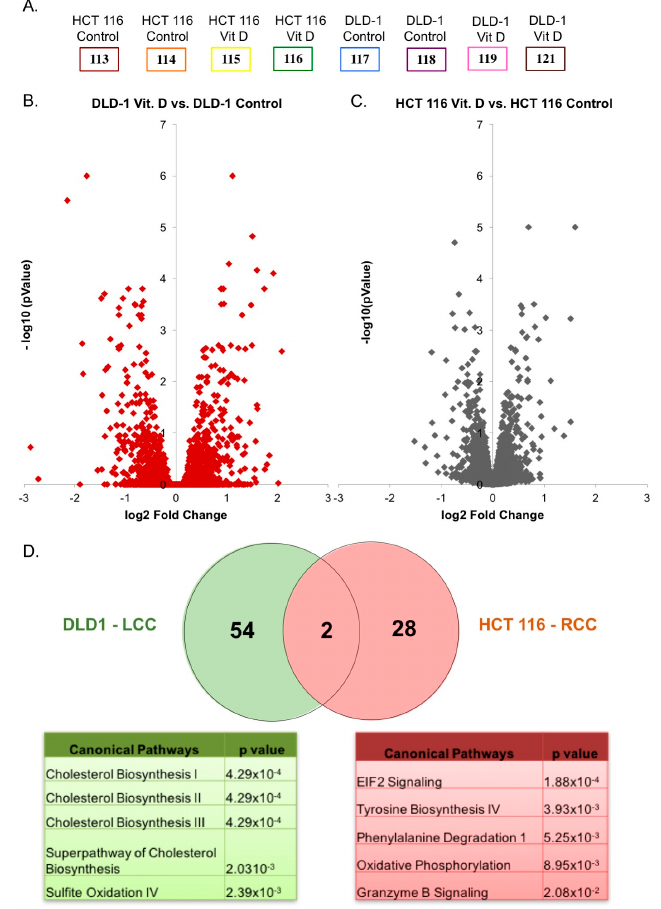
Figure 3. ( A ) Experimental setup of iTRAQ 8-plex experiment for quantitative proteomics. Each biological condition was labeled in duplicate; ( B ) Volcano plot of proteomic data (proteins were ranked according to their p -value (y-axis) and their relative abundance ratio (Log2 fold change) between DLD-1 treated vs. control (x-axis)). Proteins with a p -value of <0.01 and log2 fold change ± 1.5 were considered differentially regulated; ( C ) Volcano plot of proteomic data (proteins were ranked according to their p -value (y-axis) and their relative abundance ratio (Log2 fold change) between HCT 116 treated vs. control (x-axis)). Proteins with a p -value of <0.01 and log2 fold change ± 1.5 were considered differentially regulated; ( D ) Venn diagram showing overlap between differentially regulated proteins of DLD-1 and HCT 116 cells treated with calcitriol. Ingenuity Pathway Analysis was used to look at the canonical pathways enriched due to differentially regulated proteins in DLD-1 and HCT 116 cells treated with calcitriol and is represented in the